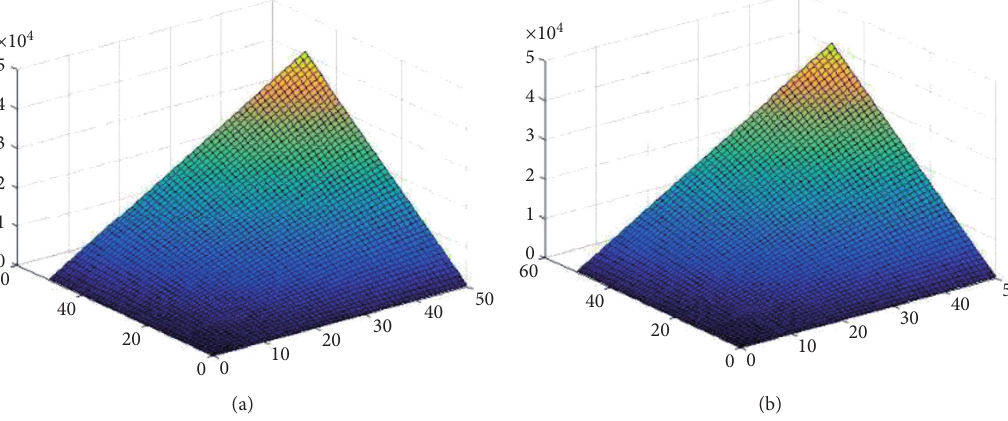
Figure 7: Inverse Randi´c index plotted in 3D.